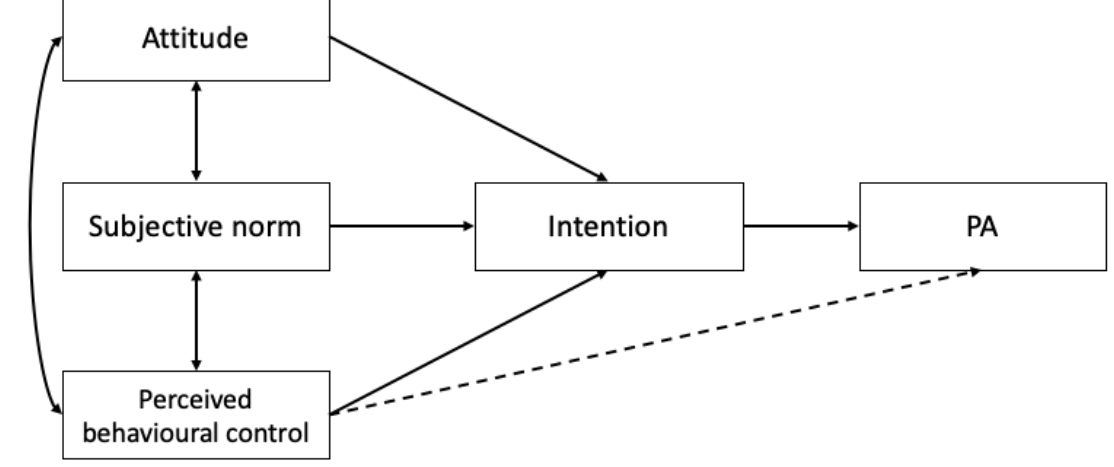
Figure 1 . Theory of planned behaviour